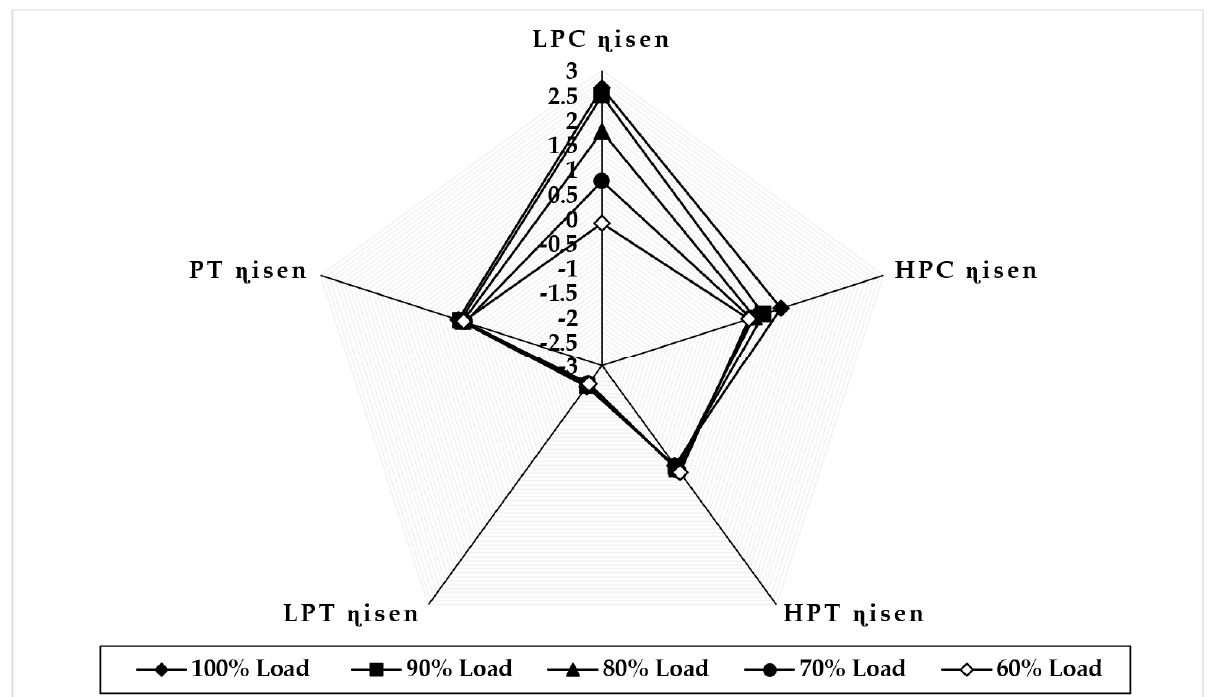
Figure 13. Deviation in component isentropic efficiency due to LPT fouling at 100% fault severity at full − load and part − load operation.